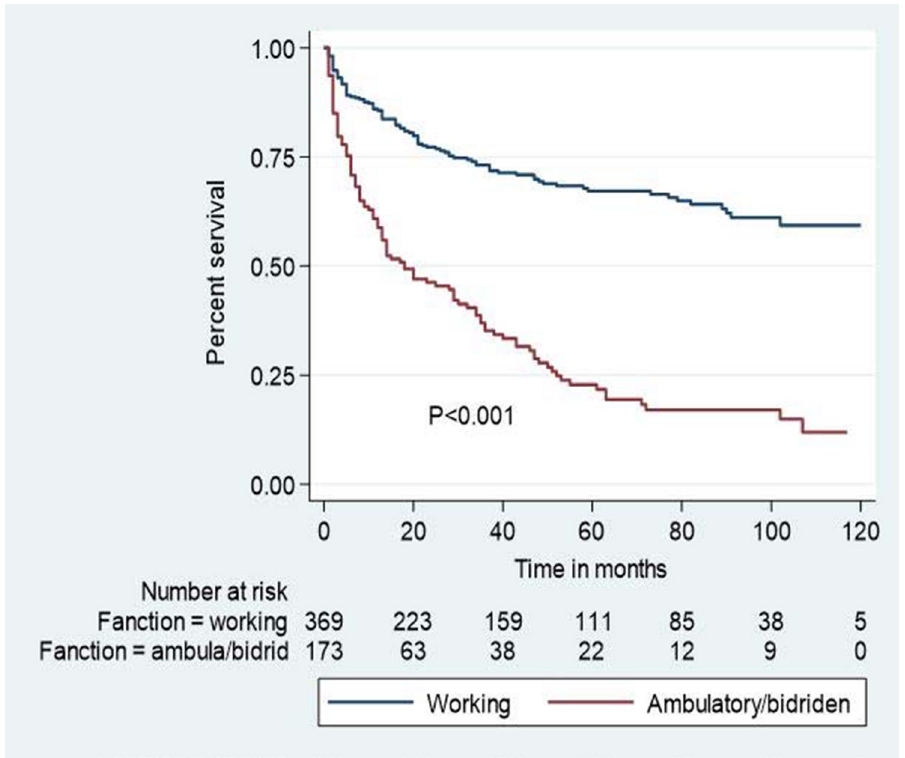
Figure 3. Kaplan–Meier survival estimates among HIV patients in Bichena health center, Amhara, North West, Ethiopia, January 1, 2008—December 30, 2017, by last functional